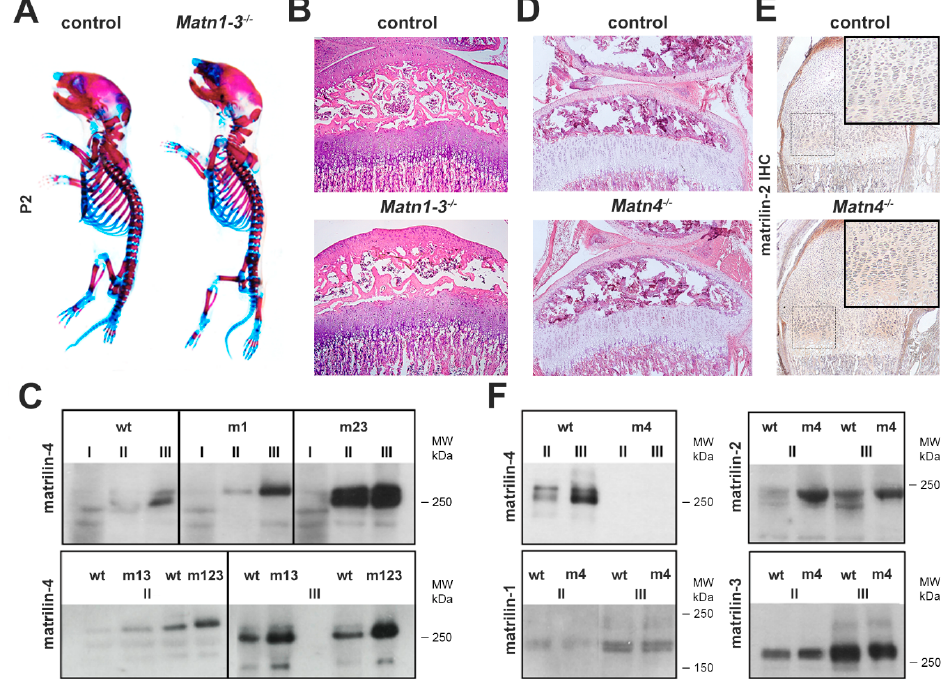
Figure 1. Biochemical compensation among matrilins. ( A ) Whole-mount skeletal staining at postnatal day 2 (P2) shows no obvious skeletal defects in mice lacking matrilin-1, -2 and -3 ( Matn1-3 − / − ) compared to wild type. ( B ) HE staining of the proximal tibia (original magnification × 10) of the knee joint indicates normal growth plate and articular cartilage structures in Matn1-3 − / − mice at 4 weeks of age. ( C ) Western blot analyses of sequential cartilage extracts (I-neutral salt; II-high salt/EDTA; III- GuHCl) from newborn mice indicates upregulation of matrilin-4 in mice lacking matrilin-1